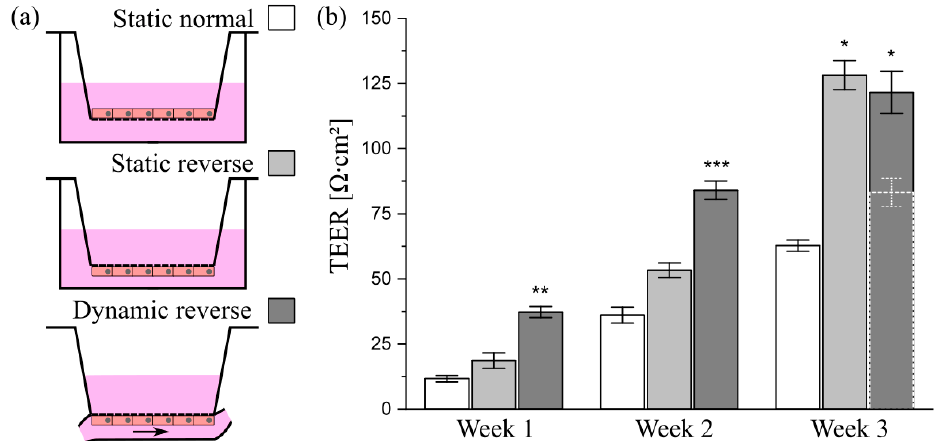
Figure 8. Influence of culture conditions on the barrier function of HT29-MTX cells. ( a ) Illustration of culture conditions with cells seeded either onto the top or bottom of Transwell ® -insert membranes, termed as “normal” and “reverse”, and cultured under static or dynamic conditions. ( b ) Barrier function of HT29-MTX cells cultured under “Static normal” (white), “Static reverse” (light gray) and “Dynamic reverse” (dark gray) condition as quantified by TEER measurements at various time points. Data presented as mean ± SEM ( n = 4–12). Dotted bar (Dynamic reverse—Week 3) represents raw data prior to correction of the value for the surface area. * p ≤ 0.05; ** p ≤ 0.005 and *** p ≤ 0.0005 compared to corresponding “Static normal”.